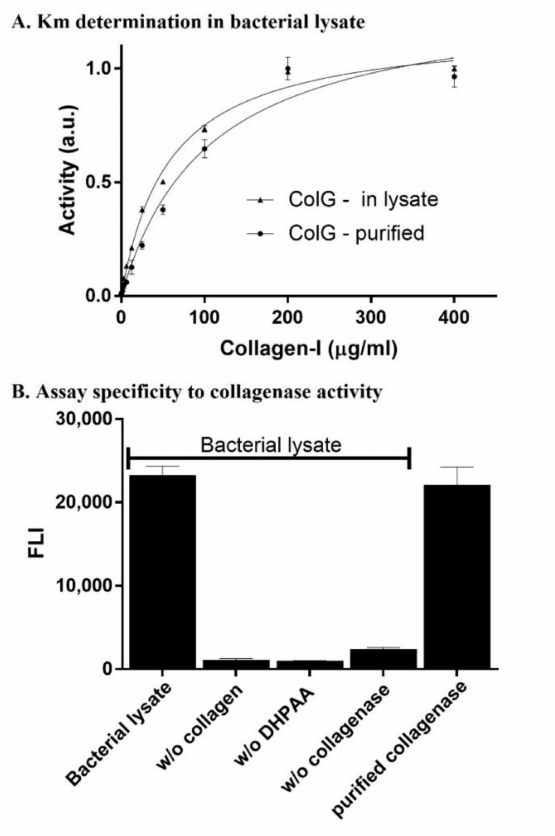
Figure 2. Enzymatic activity and specificity of ColG in bacterial lysate. ( A ) K M determination for the purified and bacterial expressed ColG in the lysate. Triplicates of variable concentrations of the substrate collagen were incubated with each of the enzymes. Fluorescence intensity was read after the reaction reached equilibrium and normalized. ( B ) A single concentration of collagen was incubated with ColG, and assay specificity was validated via the depletion of the substrate or enzyme from the reaction. The left- and rightmost bars show the full reaction in the presence of collagen in the lysate and purified collagen, respectively. The three middle bars show the negative control reaction in which one substance of the reaction was depleted in each